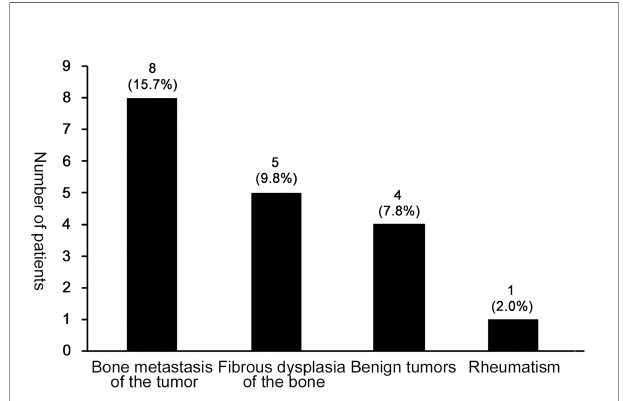
FIGURE 3 | The misdiagnosis condition in patients with PDB. The most frequent misdiagnosed disease was bone metastasis of the tumor (15.7%, 8/ 50), followed by fi brous dysplasia of the bone (9.8%, 5/50), benign tumors (7.8%, 4/50) and rheumatism